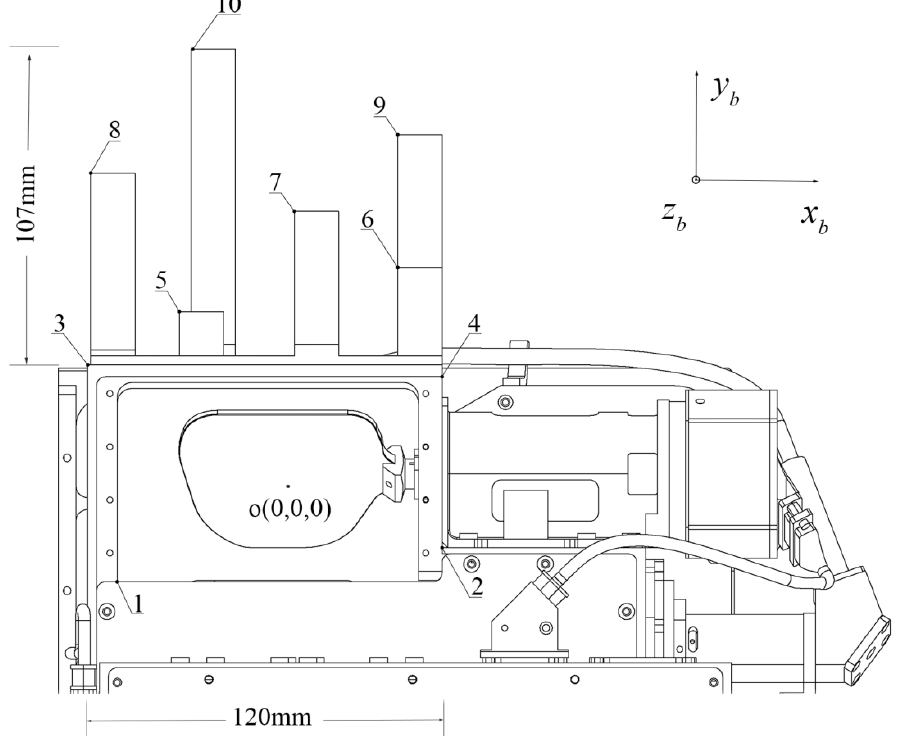
Figure 2. Additional structural part and calibration points mounted on the top of the TDI system. Points 1 to 10 are specially set marker points for determining the datum transformation parameters between the TDI body coordinate system and the ground coordinate system. Among them, points 1 and 2 are located on the TDI device itself, and points 3 to 10 are located on the structural part installed at the top of the TDI. The structure part itself is not part of the TDI, it is only used to determine the rigid transformation parameters. The height difference of the structural parts is 107 mm, and the width of the TDI laser exit window is about 120 mm. Point “o” is the origin of the TDI body coordinate system, and 𝑥 𝑏 , 𝑦 𝑏 and 𝑧 𝑏 are the coordinate axes.